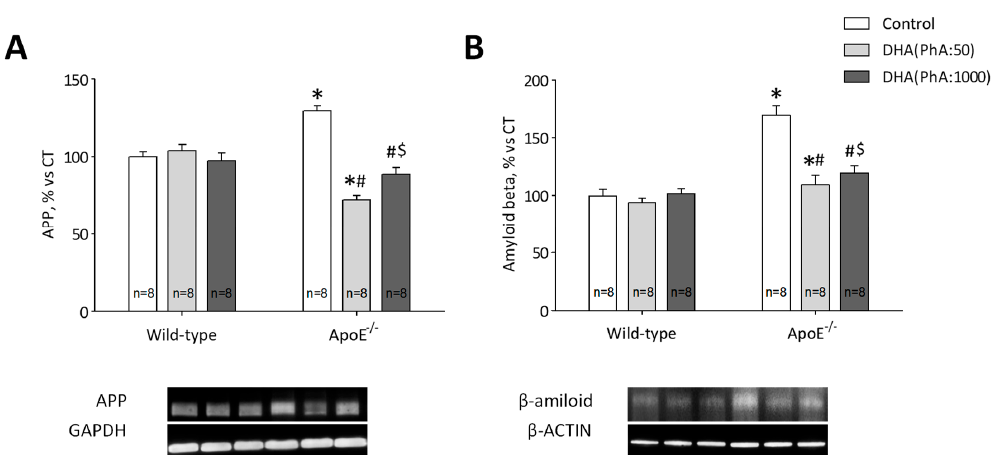
Figure 3. Effects of DHA (PhA:50) and DHA (PhA:1000) on relative protein expression of ( A ) amyloid precursor protein (APP) and ( B ) amyloid beta (Aß) in hippocampus of ApoE − / − and wild-type mice. Data show mean ± SEM. * p < 0.05 compared to control wild-type mice; # p < 0.05 compared to control ApoE − / − mice; $ p < 0.05 compared between DHA (PhA:50) and DHA (PhA:1000) in ApoE − / − mice. ( n = 8).